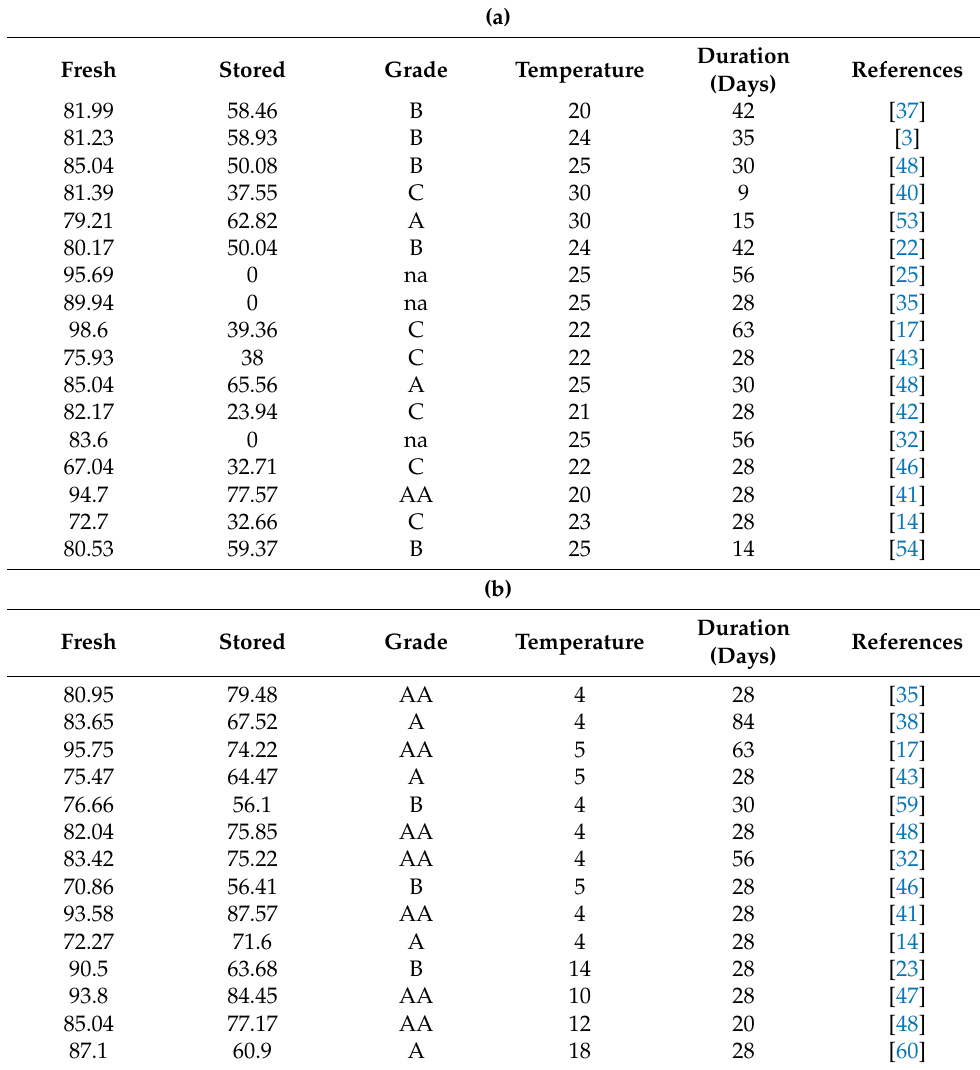
Table 3. ( a ) Effects of storage time and temperature (ambient) on Haugh unit values. ( b ) Effects of storage time and temperature (low) on Haugh unit